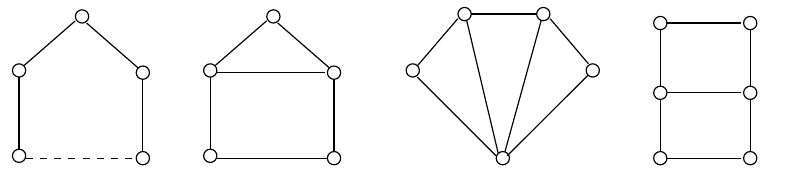
Figure 2. The minimal forbidden subgraphs of distance-hereditary graphs: from left to right, the hole , the house , the fan , and the domino . Dashed lines represent paths of length at least